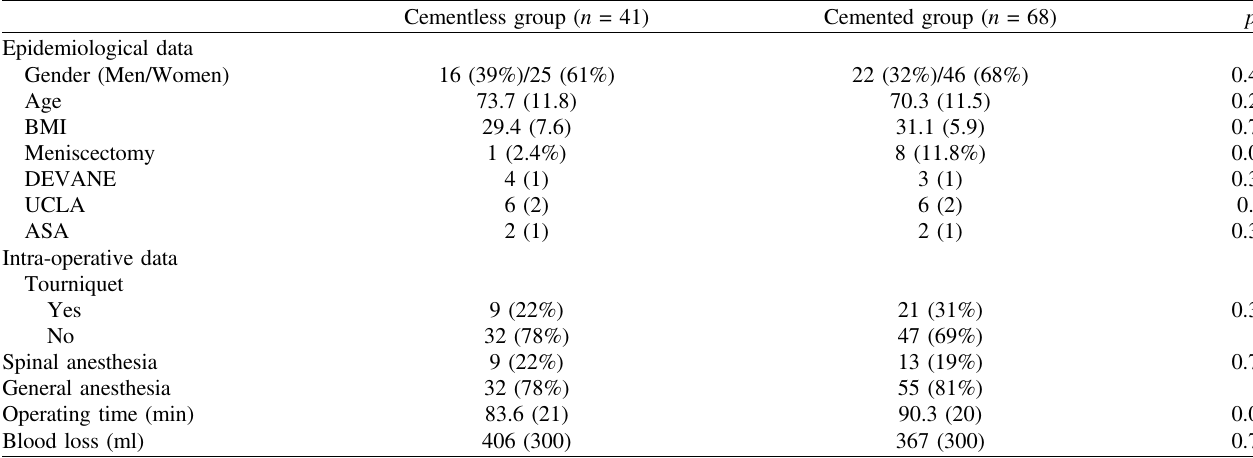
Table 1. Epidemiological and intra-operative data.